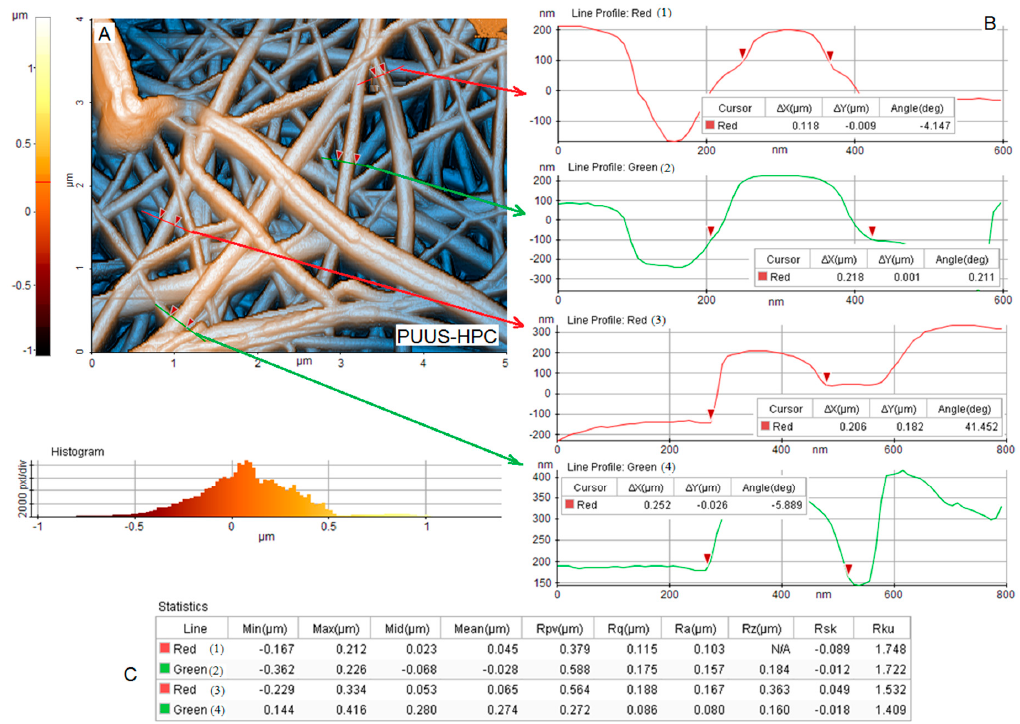
Figure 5. AFM morphology of PUUS-HPC nanofibrous composite mats: ( A ) 2D image of AFM analysis; ( B ) the diameters of four selected nanofibers (noted with red and green line); and ( C ) roughness values.